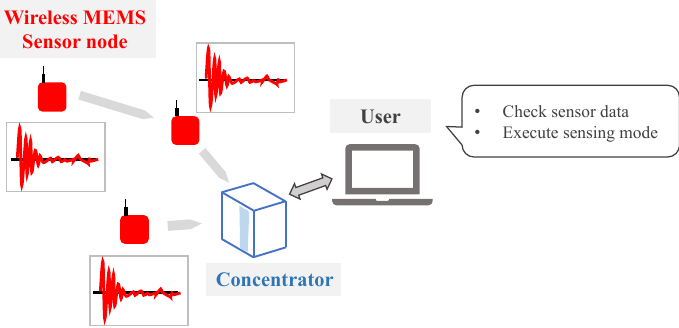
Figure 3. System structure of battery-powered wireless MEMS accelerometer